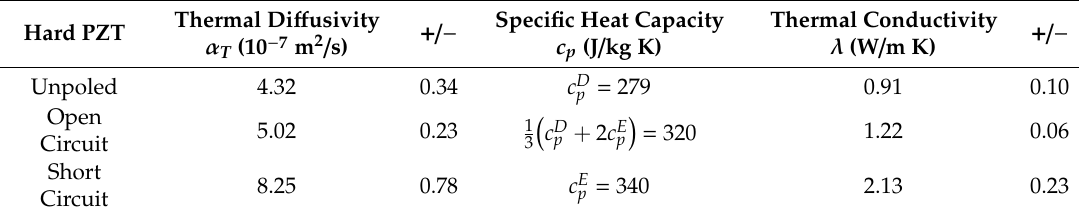
Table 1. Thermal di ff usivity, specific heat capacity, and thermal conductivity of a Hard PZT, for unpoled and poled under di ff erent electrical boundary